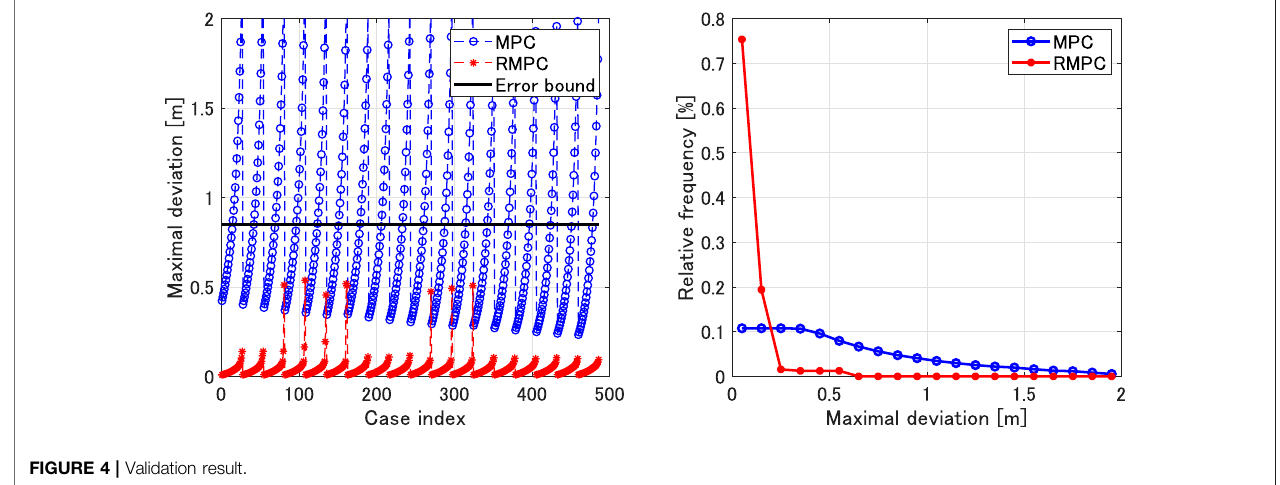
FIGURE 4 | Validation